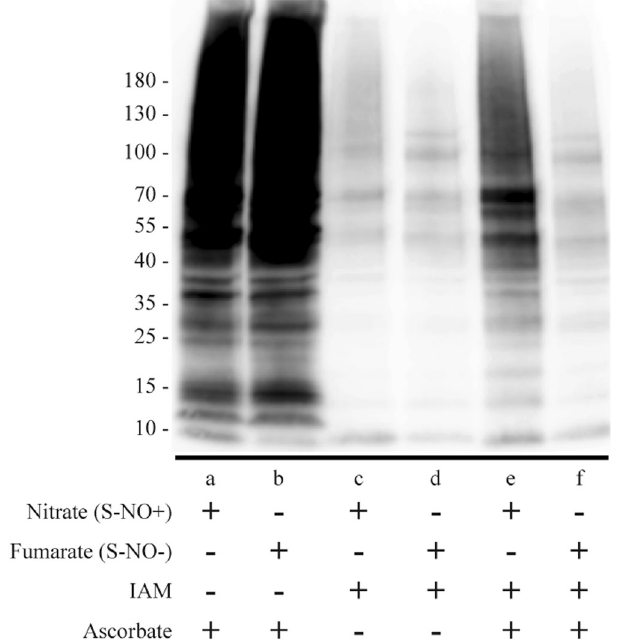
Fig. 2 Validation of the biotin-switch method to detect protein S- nitrosylation in E. coli . Whole proteins were extracted from E. coli planktonic cultures grown under S- nitrosylating (S-NO + , anaerobic with excess nitrate), or non- S- nitrosylating conditions (S-NO − , anaerobic with fumarate). Proteins were then processed following the biotin-switch technique, except that some samples were not blocked with IAM (lanes a, b), or not reduced with ascorbate (lanes c, d), before labeling with IAM-biotin and immunodetection using avidin-HRP antibodies. (Fig. 2 lane f). This indicated that the use of IAM and ascorbate could selectively label E. coli S- nitrosylated proteins in our experimental conditions. To study potential modi fi cations of protein S- nitrosylation